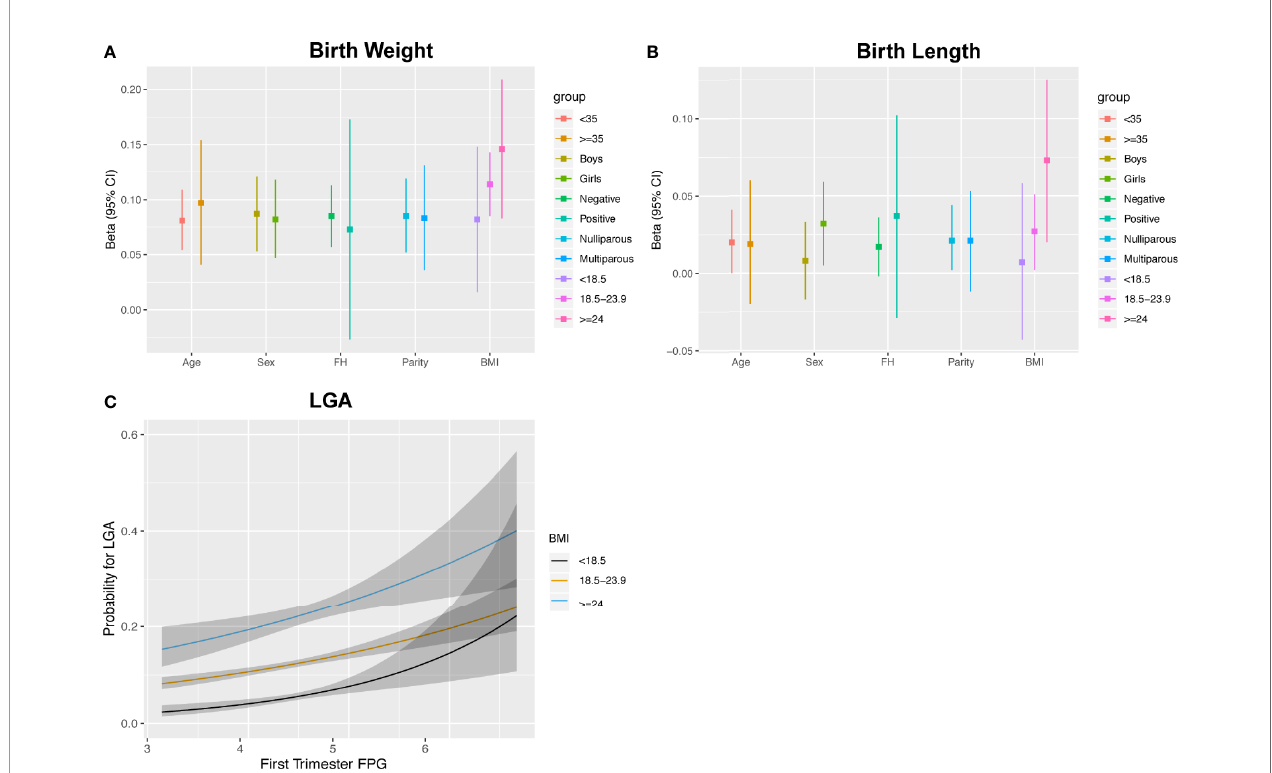
FIGURE 5 | Associations between maternal FPG with birth weight (A) , birth length (B) and the estimated probability for LGA strati fi ed by pre-pregnancy BMI (C)